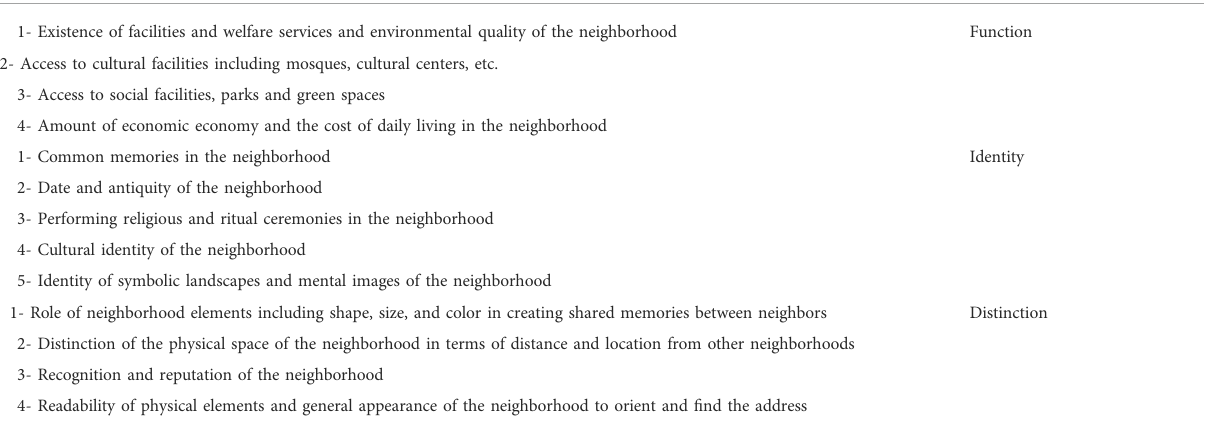
TABLE 2 Operational de fi nition of indicators related to the location branding variable (Source: Authors)